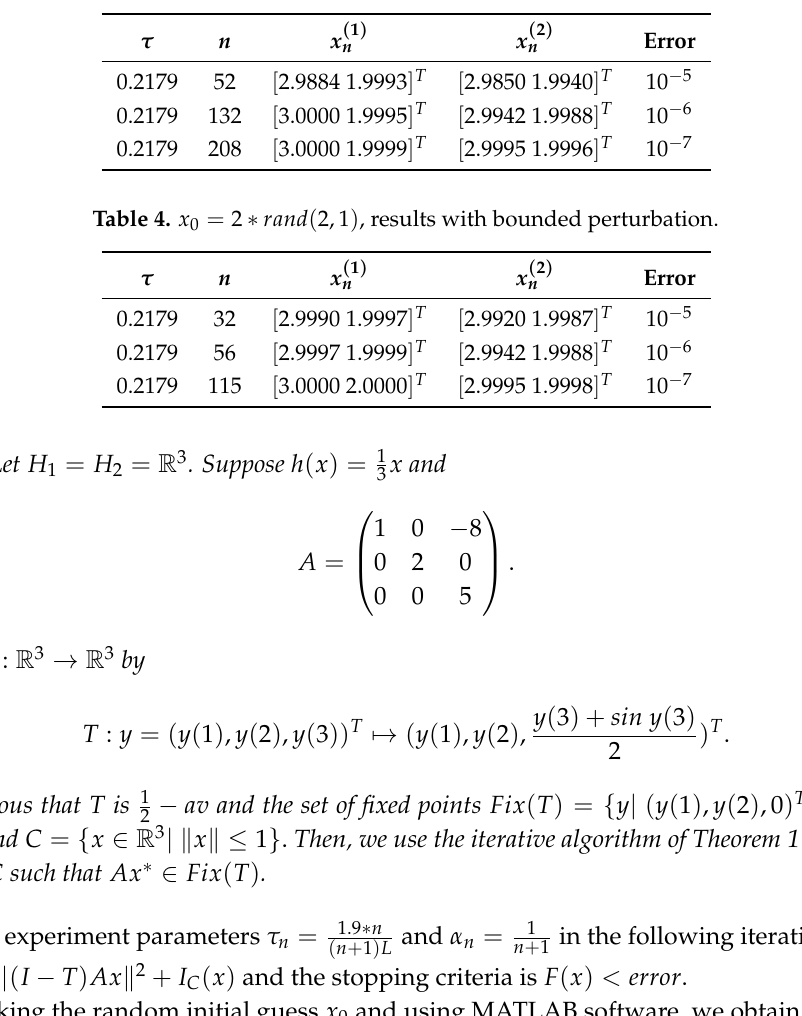
Table 3. x 0 = 2 ∗ rand ( 2,1 ) ,results without bounded perturbation.